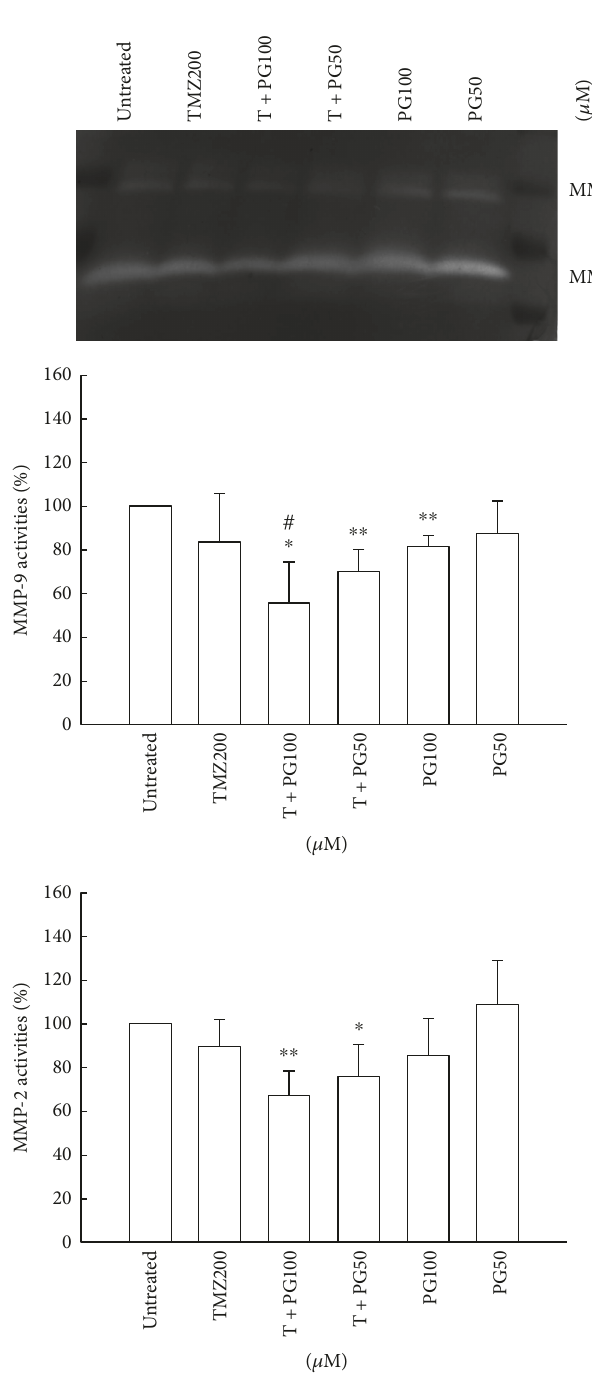
Figure 3: Analysis of MMP-2 and MMP-9 activities with TMZ, PG, or TMZ/PG treatment. U87MG cells (2 × 10 6 ) were plated in 100mm cultured dishes for 24 h and then treated with TMZ (200 μ M), PG (50 or 100 μ M), or their combination for 48 h. After treatment, the cultured media were collected and then centrifuged at 12,000 × g for 10min at 4 ° C to obtain supernatants. Aliquot protein (50 μ g) was used to evaluate the activities of MMP-2 and MMP-9 by zymography. These experiments were performed at least three times; a representative experiment is presented. Data indicate the densitometric values of various treated groups normalized to their corresponding untreated group. Signi fi cant di ff erences for the untreated group and TMZ group were ∗ P < 0 05 , ∗∗ P < 0 01 , and # P < 0 05